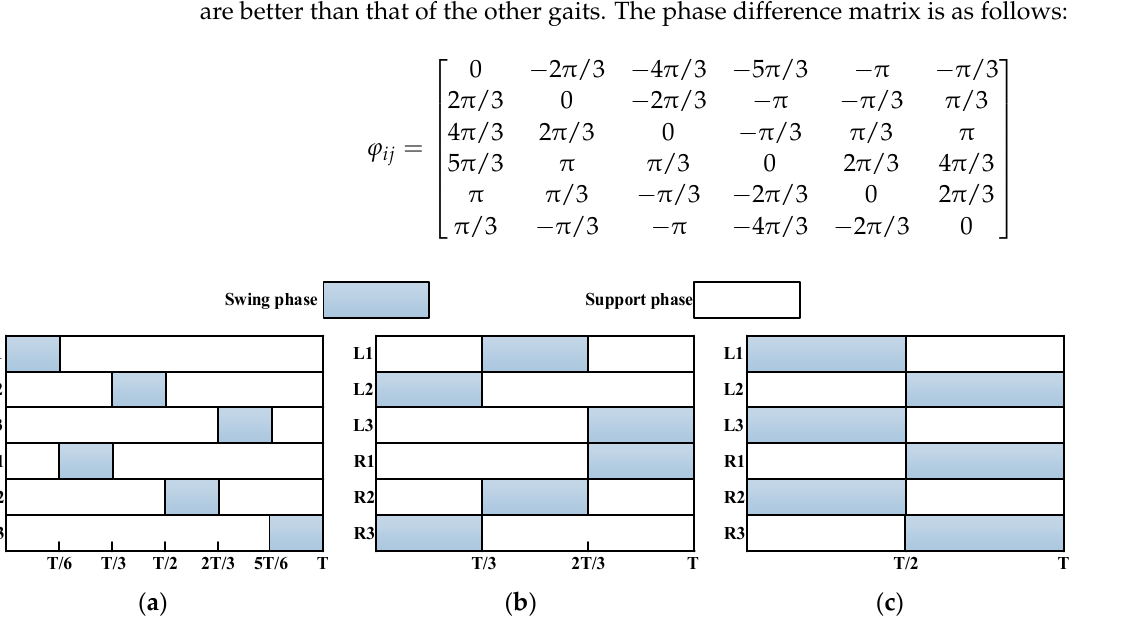
Figure 5. The phase diagram of different gaits in a period: ( a ) the wave gait; ( b ) the tetrapod gait; ( c ) the tripod gait.